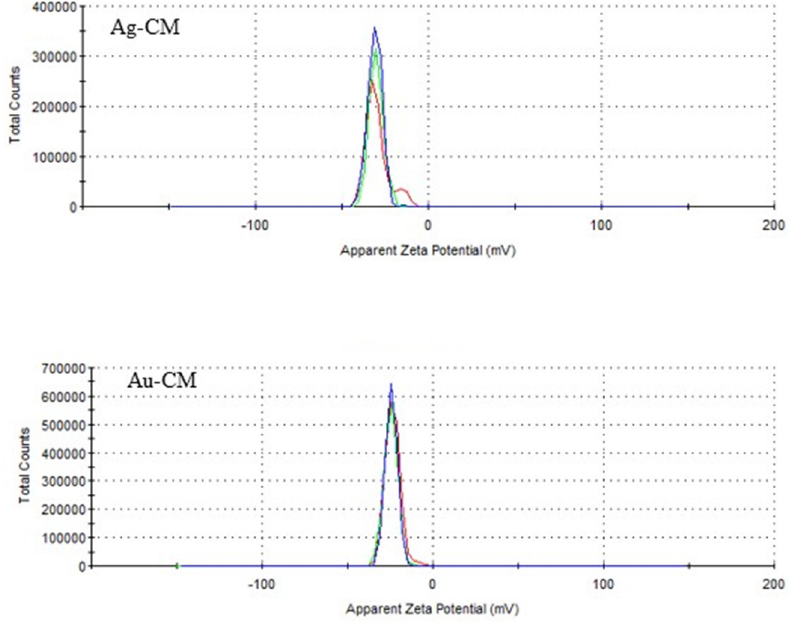
Figure 3. Zeta potential of silver and gold nanoparticles biosynthesized with Cornus mas fruit extract as source of reducing and capping agents.